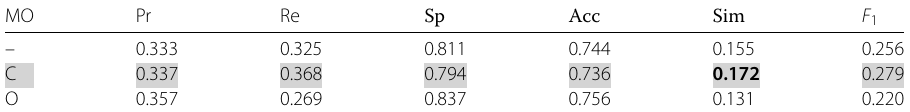
Table 2 Evaluation results for the predicted masks of the GMM after applying post-processing methods